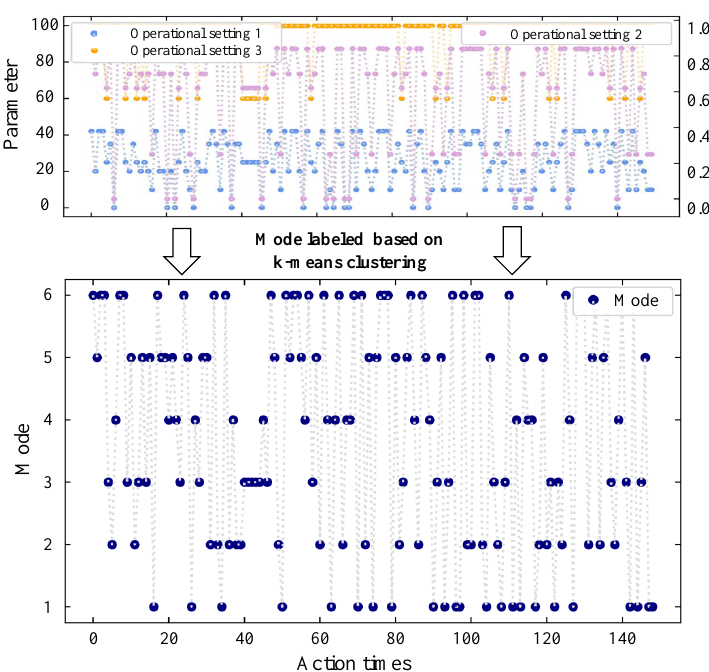
Figure 6. Mode labeled from three operational settings based on k-means clustering algorithm, where the data are from the first sample of